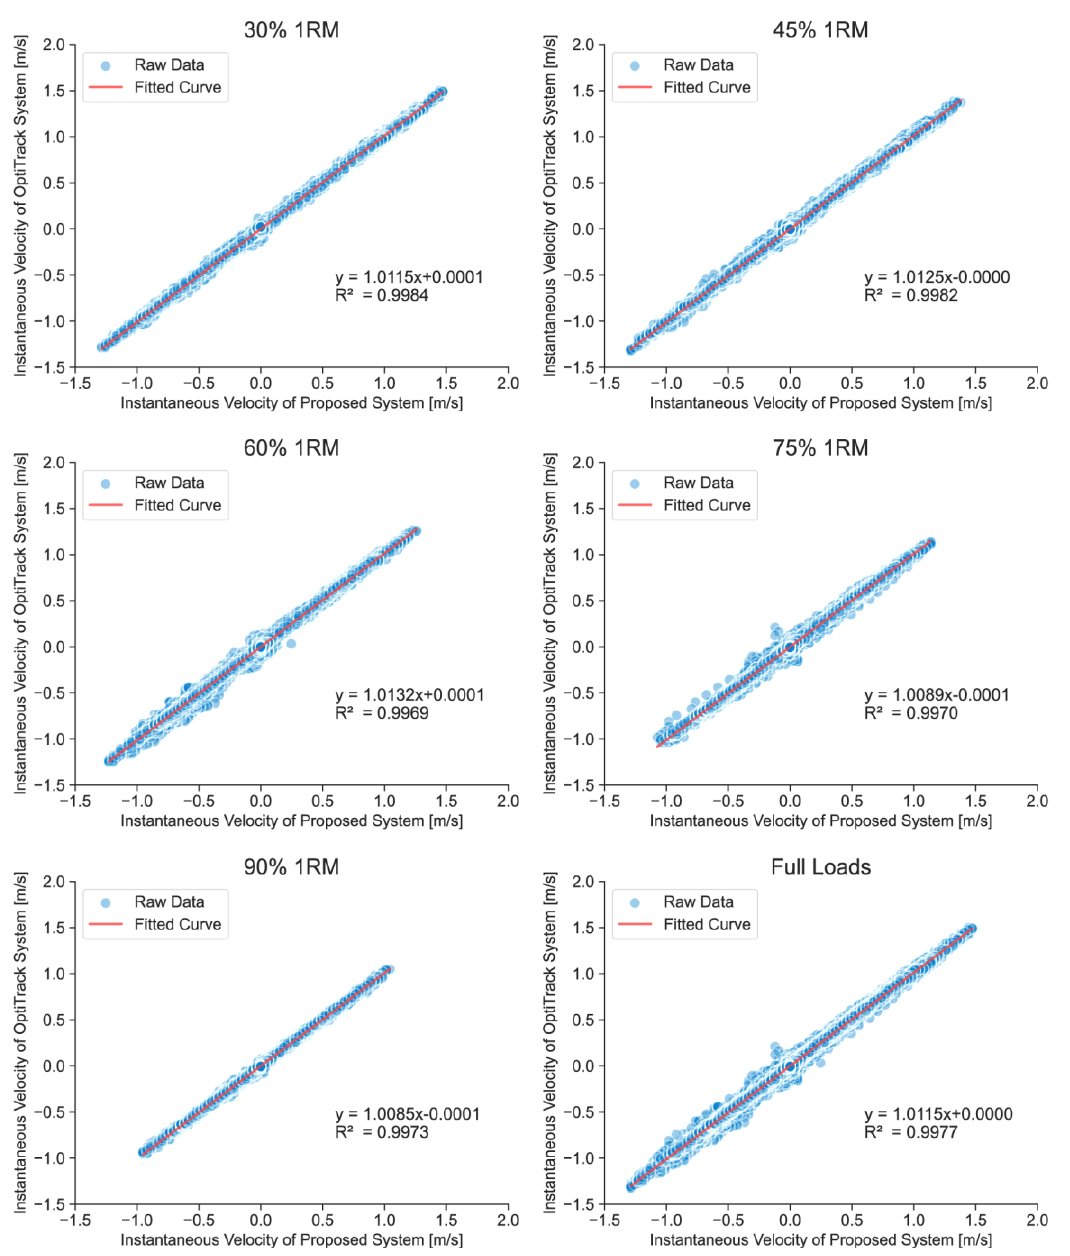
Figure 9. Linear regressions of the instantaneous velocities under different loads, measured by the FRTMS versus the OptiTrack system. The Full Loads graph is the regression of all relative loads’ instantaneous velocities. The positivity or negativity of the velocities represents the direction of movement: negative velocity means downward movement, while positive velocity means upward movement.